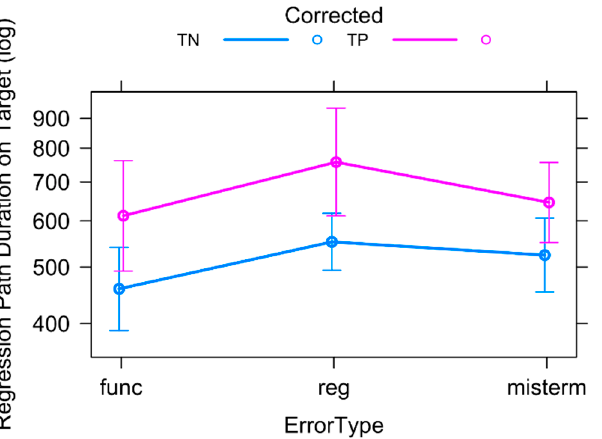
Figure 12. Interaction between Corrected and Error Type on target text regression path duration.